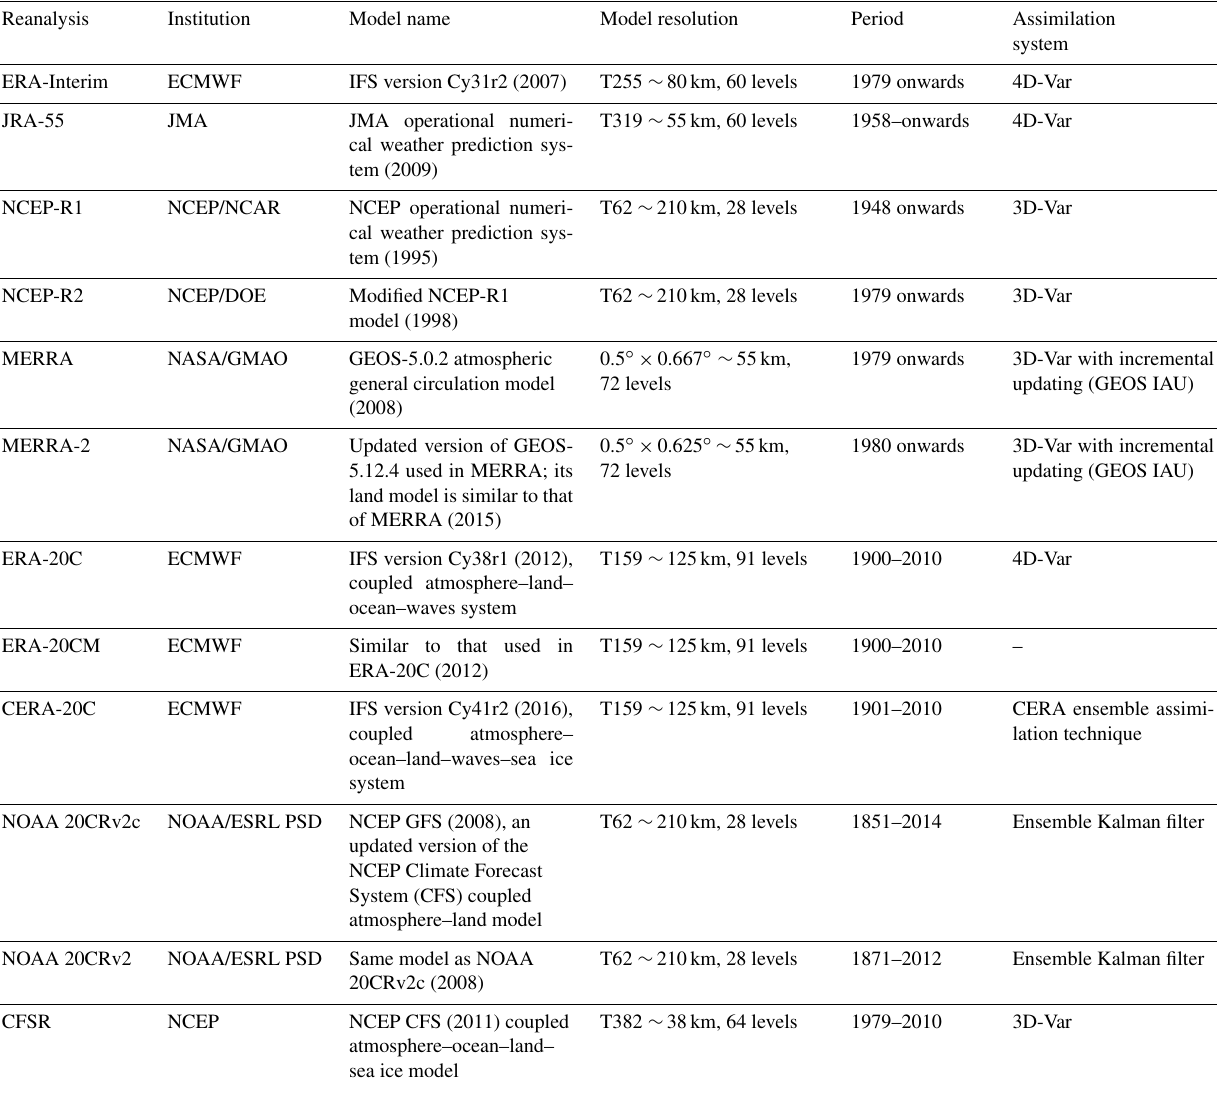
Table 1. Summary information on the 12 reanalysis products, including institution, model resolution, assimilation system, surface observa- tions associated with surface air temperatures, sea ice and sea surface temperatures (SSTs), and greenhouse gas (GHG) boundary conditions. The number in the parentheses in the model name column is the year of the version of the forecast model used. More details on each product can be found in the associated